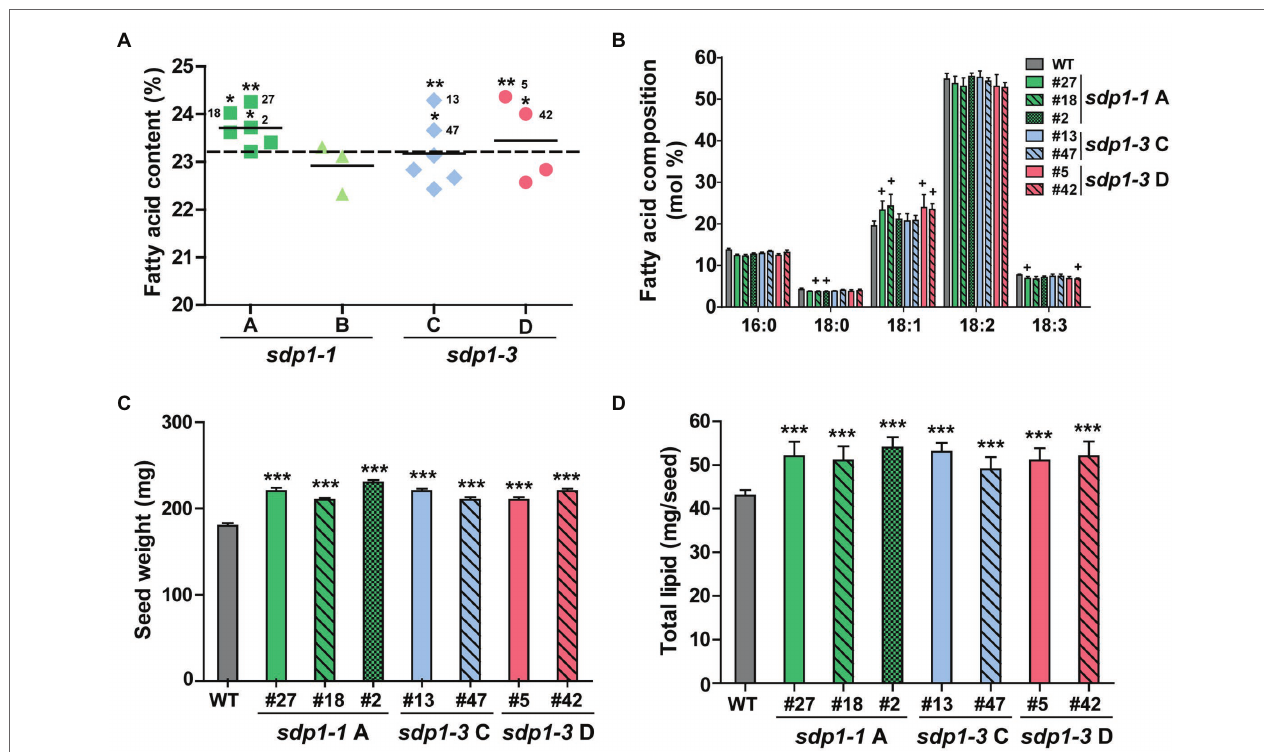
FIGURE 4 | Transgenic lines targeting GmSDP1 expression possess seeds with increased high fatty acid content. (A) Scatter plot showing the fatty acid content of seeds containing different constructs targeting SDP1 expression. Each data point corresponds to an independent transgenic line and represents the mean fatty acid content as a % of dry seed weight of T3 seeds from two plants for each line. Solid horizontal lines represent the average fatty acid content for each construct. The horizontal dashed line indicates the mean fatty acid content of seeds harvested from two control wild-type plants. Numbers denote the specific lines chosen for further compositional analysis. Statistically significant differences between wild-type and transgenic lines were determined using Student’s t -test; **, p < 0.05; *, p < 0.3. (B) Mean fatty acid composition of T3 seed harvested from two plants each for select transgenic lines. Error bars represent SD. Crosses indicate significant differences with wild-type seed (+, p ≤ 0.001; Student’s t -test). (C) Average seed weight. Values represent the mean ± SD of 45 seeds collected from two plants for each line. ***, p < 0.001 based on a two-tailed t-test. (D) Seed fatty acid content calculated on a per seed basis. Values represented the mean ± SD. ***, p < 0.001 based on a two-tailed t